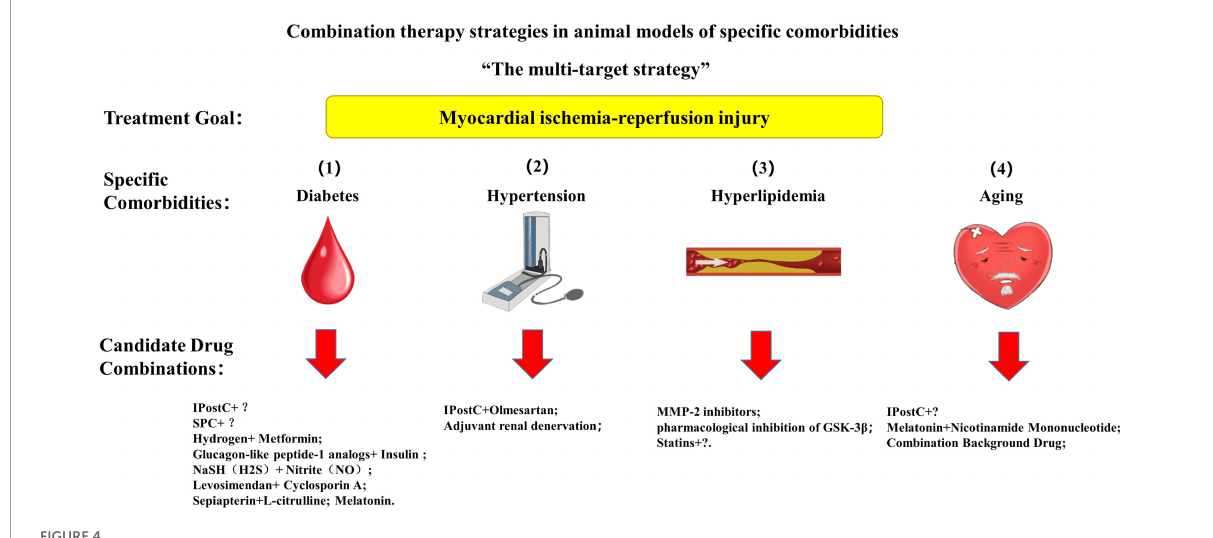
FIGURE4 A multi-target strategy for myocardial ischemia-reperfusion injury in animal models with specific comorbidities. IPostC, ischemic postconditioning; SPC, sevoflurane